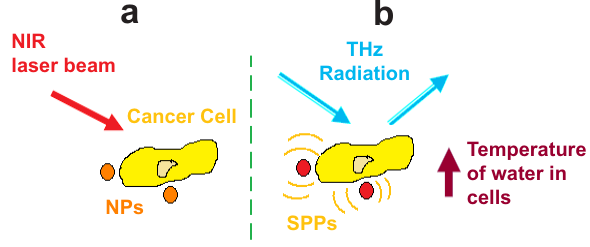
Figure 3. The hyperthermia effect. a ) First, the cancer cells are probed with nanoparticles (NPs) and are then irradiated with near- infrared (NIR) laser beams. b ) After irradiation, surface plasma polaritons (SPPs) occur and as a result the temperature of water